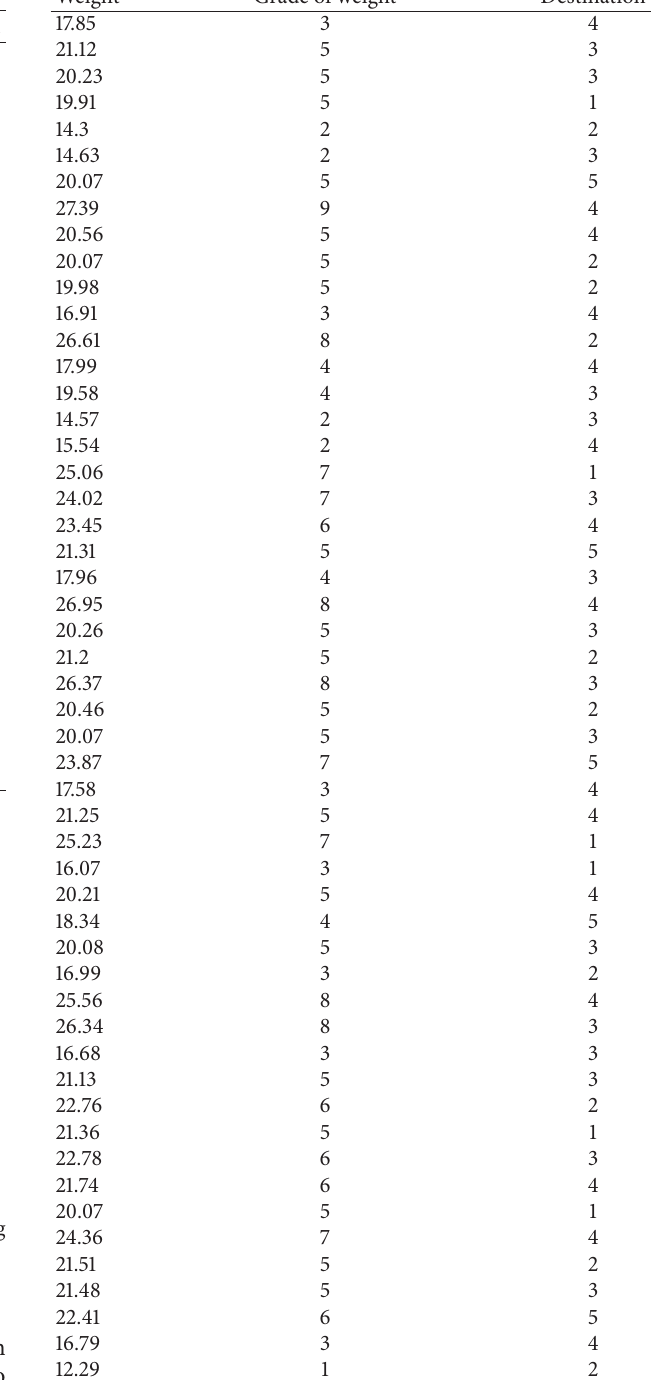
Table 1: Volume and arriving time of containers in planning horizon.